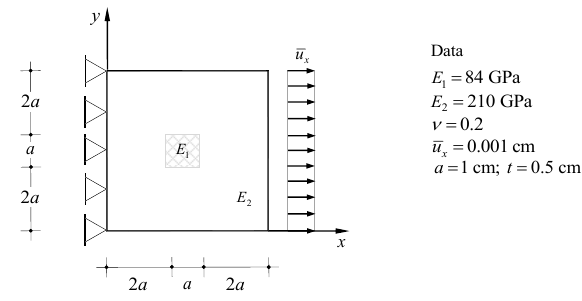
Figure 5: Plate with inclusion: geometry, loading, boundary condi- tions and material